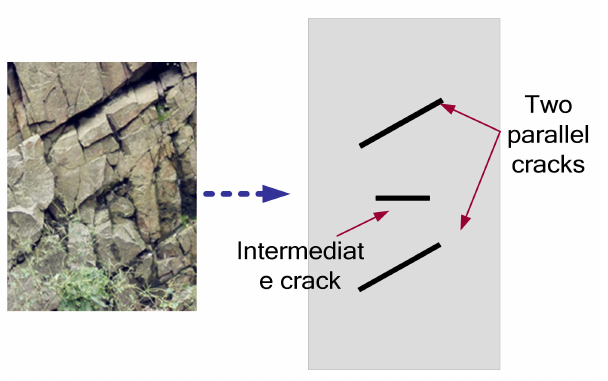
Figure 1. Multi-crack